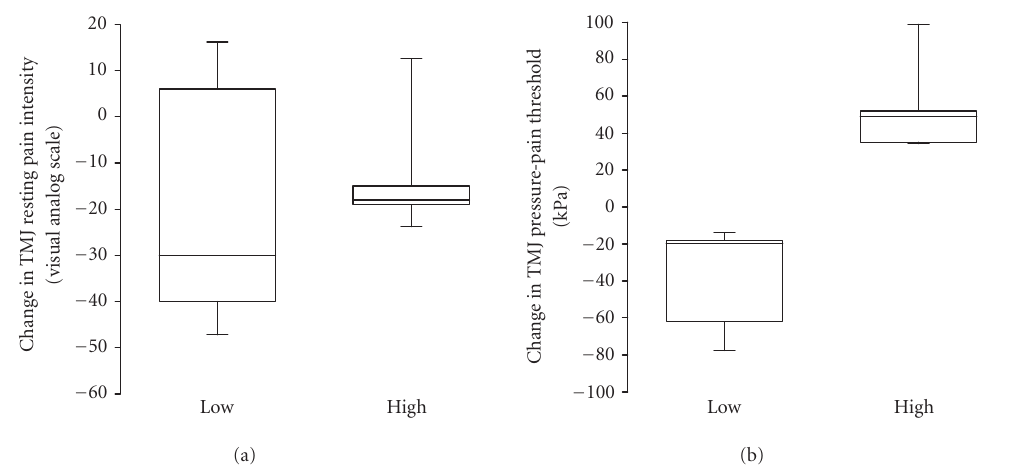
Figure 2. (a) Change in temporomandibular joint (TMJ) resting pain intensity after intra-articular glucocorticoid treatment in 7 patients with lower level than median group ( < 37nmol/L) and 3 patients with higher level than median pretreatment plasma levels ( ≥ 37 nmol/L) of serotonin (5-HT) in patients with chronic inflammatory joint disease. There was a positive correlation between 5- HT and change in resting pain intensity after treatment ( r s = 0 . 66, n = 10, P = . 040). (b) Change in temporomandibular joint (TMJ) pressure-pain threshold after intra-articular glucocorticoid treatment in 5 patients with lower level than median group ( < 37nmol/L) and 5 patients with higher level than median pretreatment plasma levels ( ≥ 37 nmol/L) of serotonin in patients with chronic inflam- matory joint disease. There was a positive correlation between 5-HT and change in pressure-pain threshold after treatment ( r s = 0 . 83, n = 10, P = . 003).